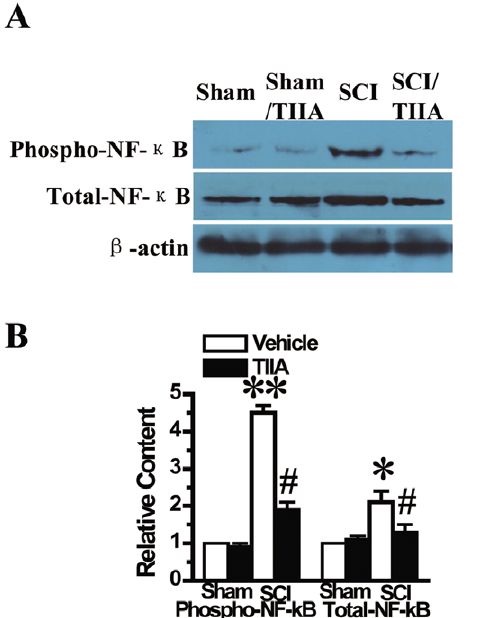
Figure 4. Effects of TIIA on NF- k B activation at 24 h after SCI. A basal expression of p-NF- k B and total NF- k B were detected by Western blot in the sham and sham/TIIA groups at 24 h after SCI, whereas NF- k B levels were increased after SCI. Treatment of TIIA (20 mg/kg) reduced the expression of NF- k B (A). The relative content of two types of NF- k B was counted (B). Bars represent means 6 SEM. * p , 0.05, ** p , 0.001 vs. sham group; # p , 0.05 vs. SCI group.